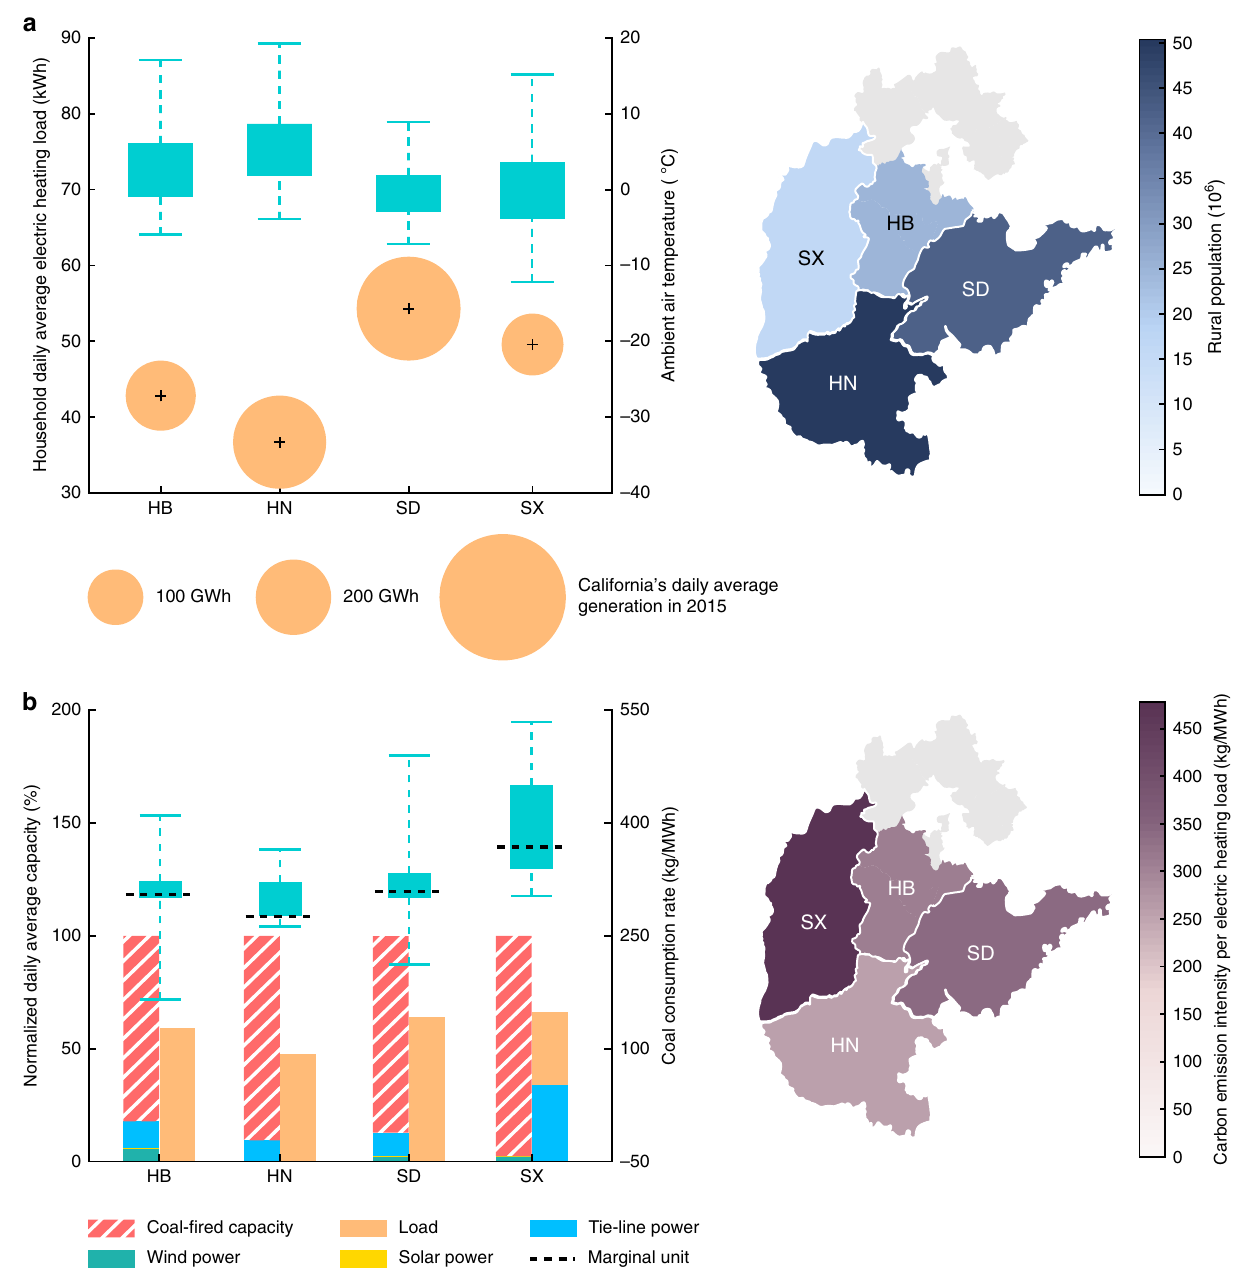
Fig. 2 Analysis of the key factors in fl uencing provincial carbon emissions caused by EHP. a Household daily average electric heating load and rural resident population (RRP) in Hebei (HB), Henan (HN), Shandong (SD), and Shanxi (SX) provinces. The left fi gure shows the relationship between the household daily average electric heating load and hourly ambient air temperature (AAT) in winter. The center of each bubble represents the load of a single household, and the radius represents the provincial daily average electric heating load of all rural residents. Each box shows the distribution of hourly AAT ( n = 1464). The right fi gure shows the RRP of four provinces, and the gray area, i.e., the northern region of HB, is excluded from the analysis due to data limitation. b Daily average generation capacity factors and carbon emission intensity per electric heating load. In the left fi gure, the bars represent the normalized generation capacity and electric load before electric heating, and the total available generation capacity is scaled to 100%. Each box shows the distribution of the thermal coal consumption rates (TCCRs) of coal- fi red generators ( n = 97 for HB, n = 153 for HN, n = 190 for SD and SX). The minimum/ maximum of each box indicates the minimal/maximal value, and the lower and upper percentiles are 25% and 75%,